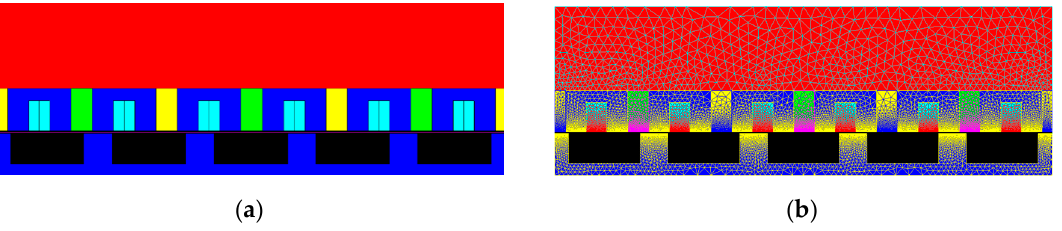
Figure 12. 2D FEM linear model geometry created by FLUX: ( a ) the complete geometry without meshing; ( b ) the complete geometry with meshing